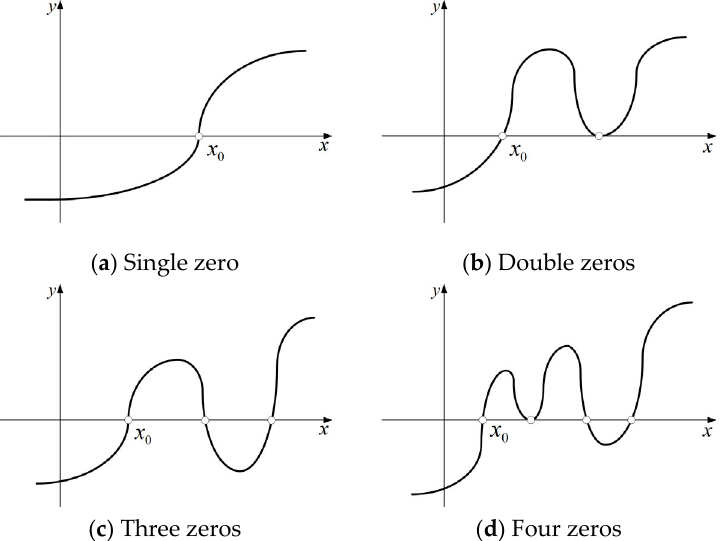
Figure 1. Zero ‐ point